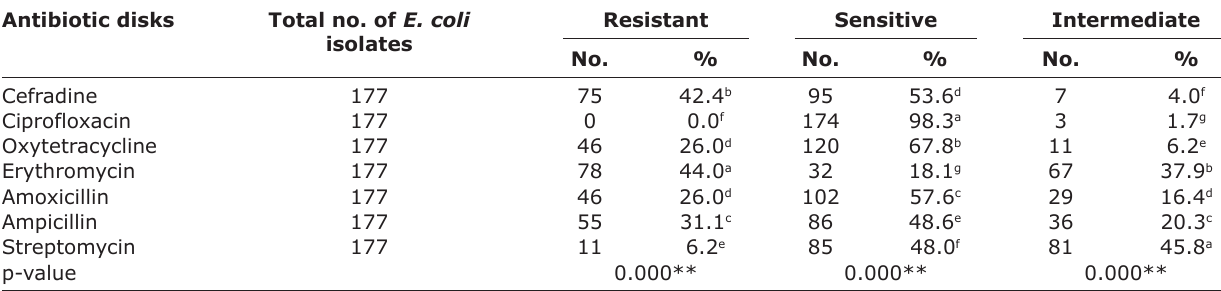
Table-10: Results of the antibiotic sensitivity test of E. coli isolated from meat and meat by-products. Antibiotic disks